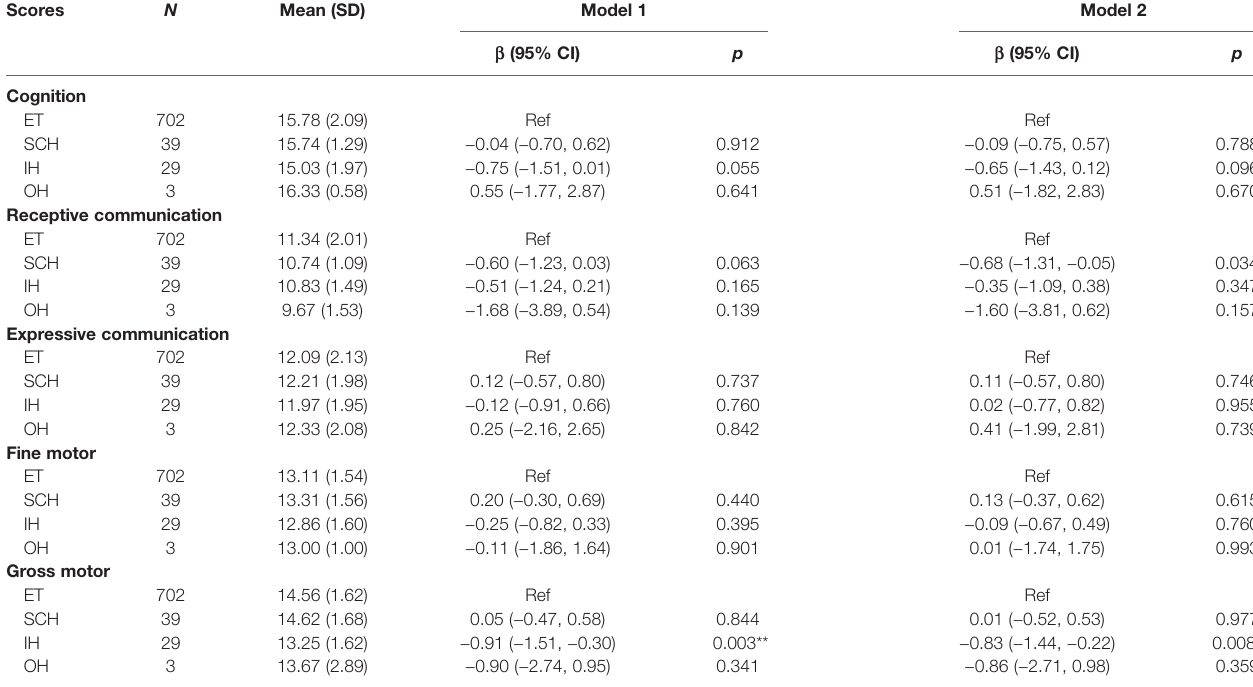
TABLE 2 | Association of maternal hypothyroidism with infant Bayley-III scores by the 2017 ATA guidelines.